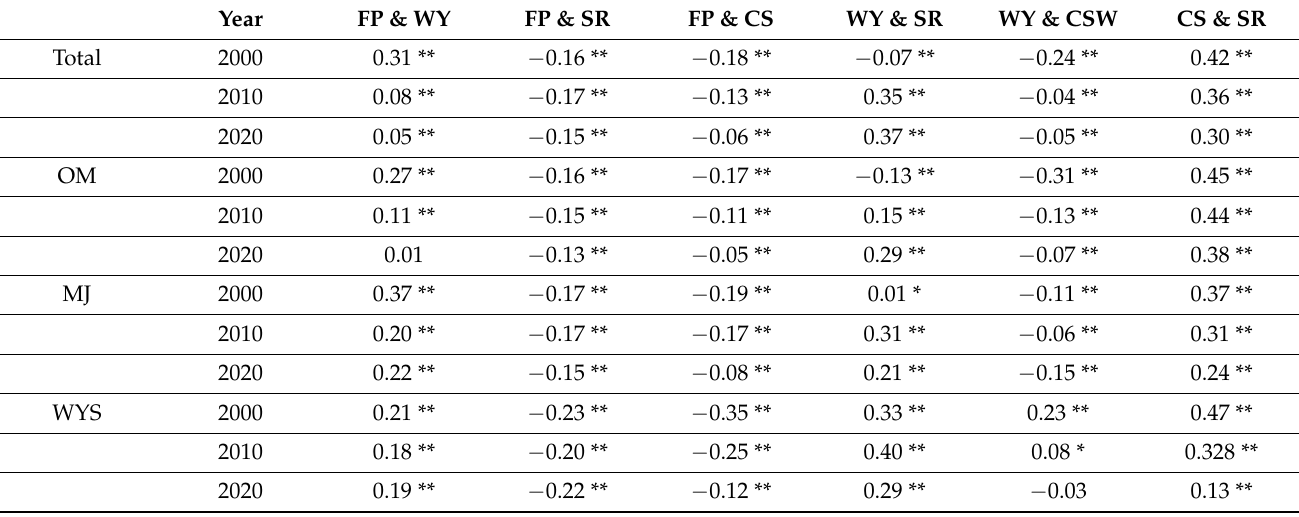
Table 4. Variations in the relationships between different ESs